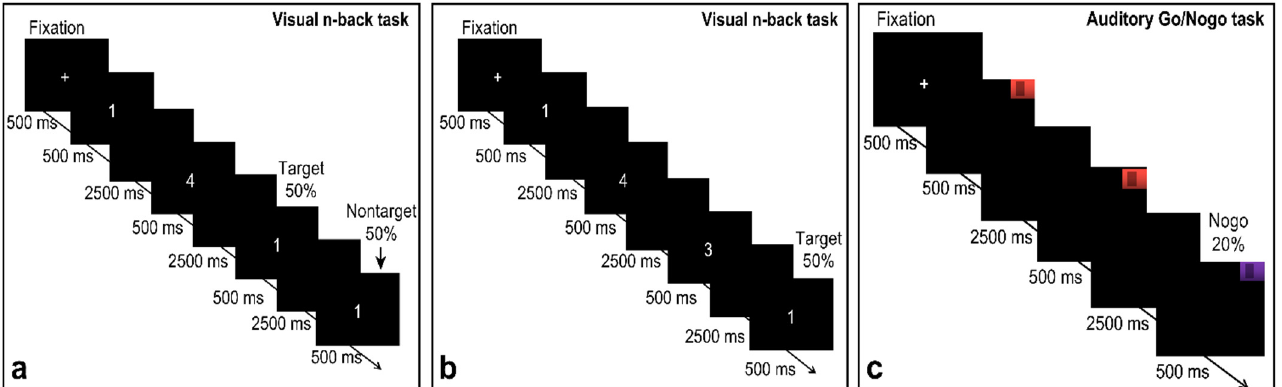
Figure 1. Single-task schematic. ( a ) represents the single visual working memory task in the 2-back condition, ( b ) represents the single visual working memory task in the 3-back condition, and ( c ) represents a single auditory working memory task.